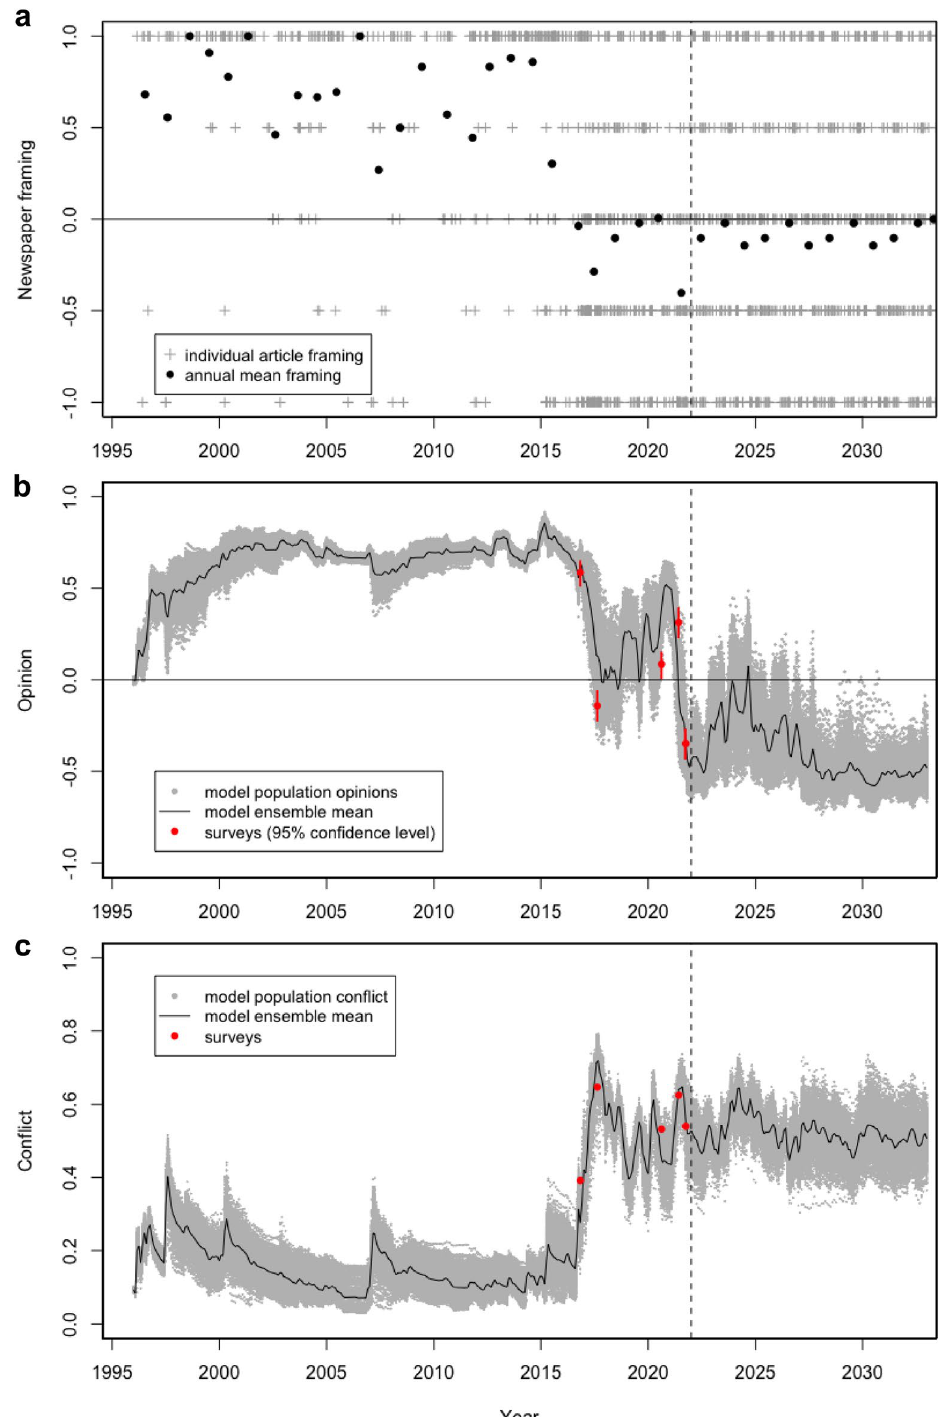
Figure 2. Time series over the historical period (January 1996 to March 2021) and a projection period based on repetition of the previous 3-years (April 2021 to March 2032). ( a ) Newspaper framing per article (grey crosses) and annual means (black points). ( b ) Modelled opinions averaged across the population (grey points) and averaged across the entire ensemble (black line). Average opinions estimated from five community surveys with 95% confidence intervals are also shown for comparison (red points). ( c ) Modelled population conflict levels (grey points) and ensemble mean conflict level (black line). Average conflict estimated from the five community surveys are also shown for comparison (red points). While no survey data was available prior to 2015, the industry has been described as having ‘an enviable social licence to operate’ 58 over that period, consistent with positive opinions and low